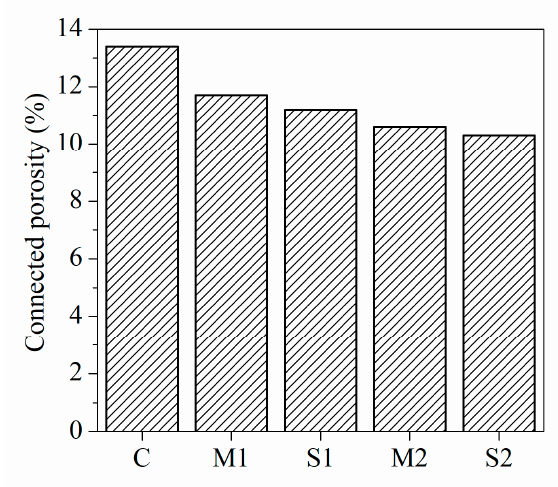
Figure 3. Connected porosity of concrete.